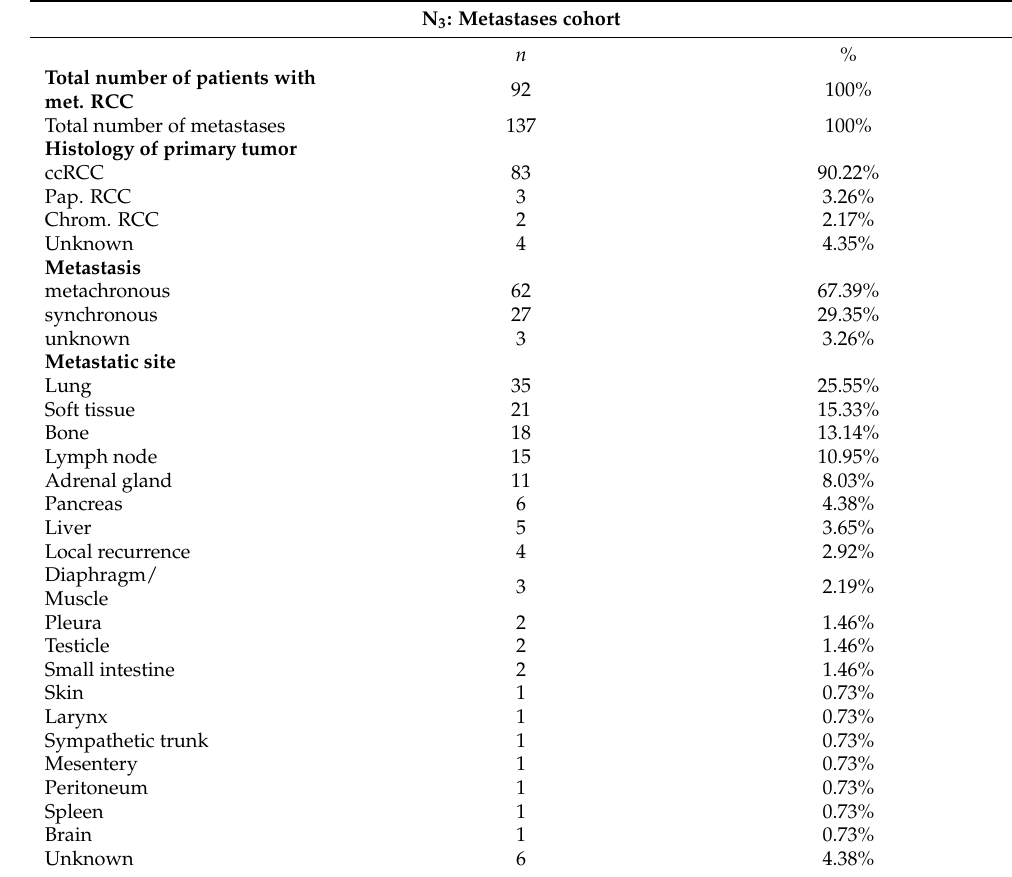
Table 3. Characteristics of patient cohort n 3 : metastatic tissue